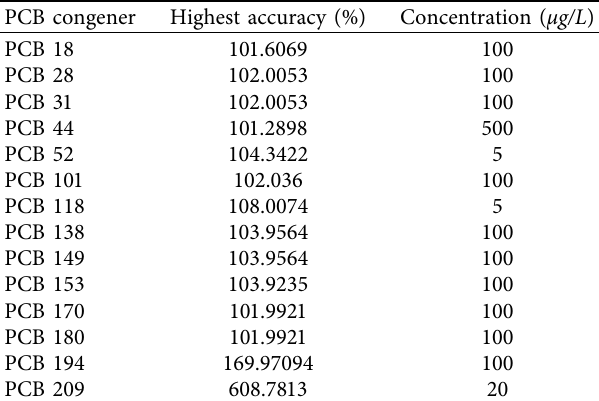
Table 3: GC-MS instrument accuracy for PCB congeners. PCB